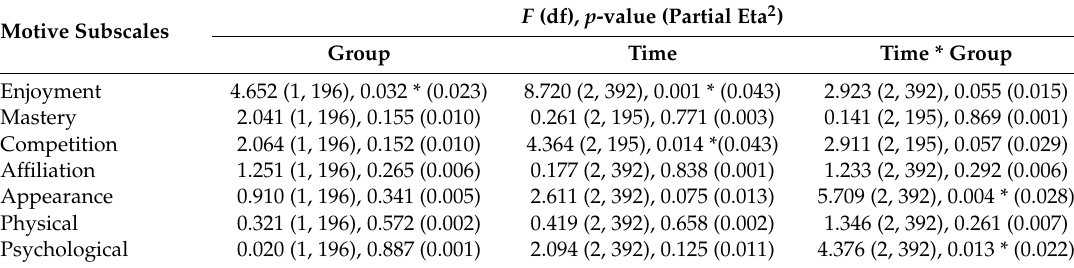
Table 3. Repeated measure of variance, F -statistics, and main e ff ects for each motive subscale.